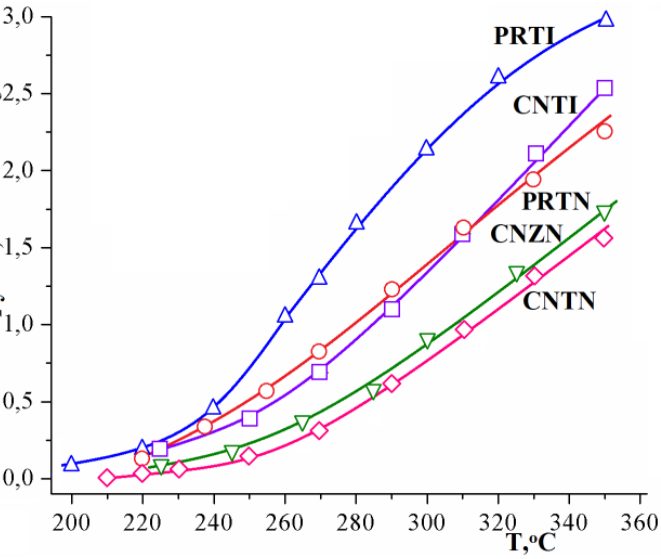
Figure 4. Temperature dependence of the hydrogen yield in the MSR using investigated catalysts. Therefore, the most probable reason is the effect of a significant difference in the defect structure of the obtained carriers. Thus, doping titania with indium oxide takes place due to the quasi-chemical reaction (3). Accordingly, in the oxygen sublattice of the oxide structure vacancies are formed. As known, such vacancies are prone to sorption of oxygen atoms of water molecules [37], and oxygen ions can form hydrogen bonds with water protons. As noted above, the support role is largely reduced to water sorption, thus it is not surprising that the use of such catalysts can provide the successful steam reforming proceeding. TiO 2 doping with pentavalent niobium oxide, on the contrary, leads to the excess appearance of oxygen ions, which can be located at the interstitial sites of the lattice. How- ever, since the close packing is formed by bulk oxygen ions in such systems, the interstitial sites have a significantly smaller size. Therefore, additional oxygen ions placement into them would lead to a significant increase in the system enthalpy. Another mechanism of charge compensation is realizing, that is the formation of cation vacancies, which also have a negative charge relative to the positions where Ti 4+ ions should have been located. Such a system can adsorb water molecules mainly due to the hydrogen bonds with water protons formation. The weakening of the support adsorption activity also leads to a decrease in the catalyst activity as a